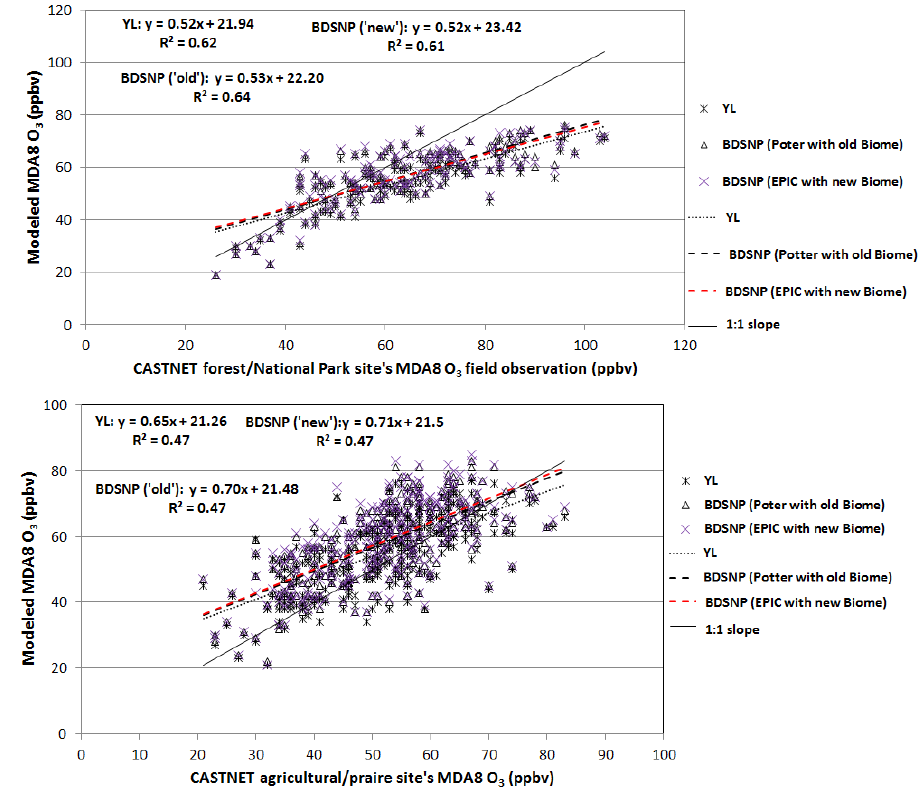
Figure 11. Comparison of the three in-line BDSNP–CMAQ cases with CASTNET MDA8 O 3 data for forest/national park sites in California (top: number of evaluation sites, n = 147) and agricultural/prairie sites in Midwest and southern USA (bottom: n = 311) for July 2011.